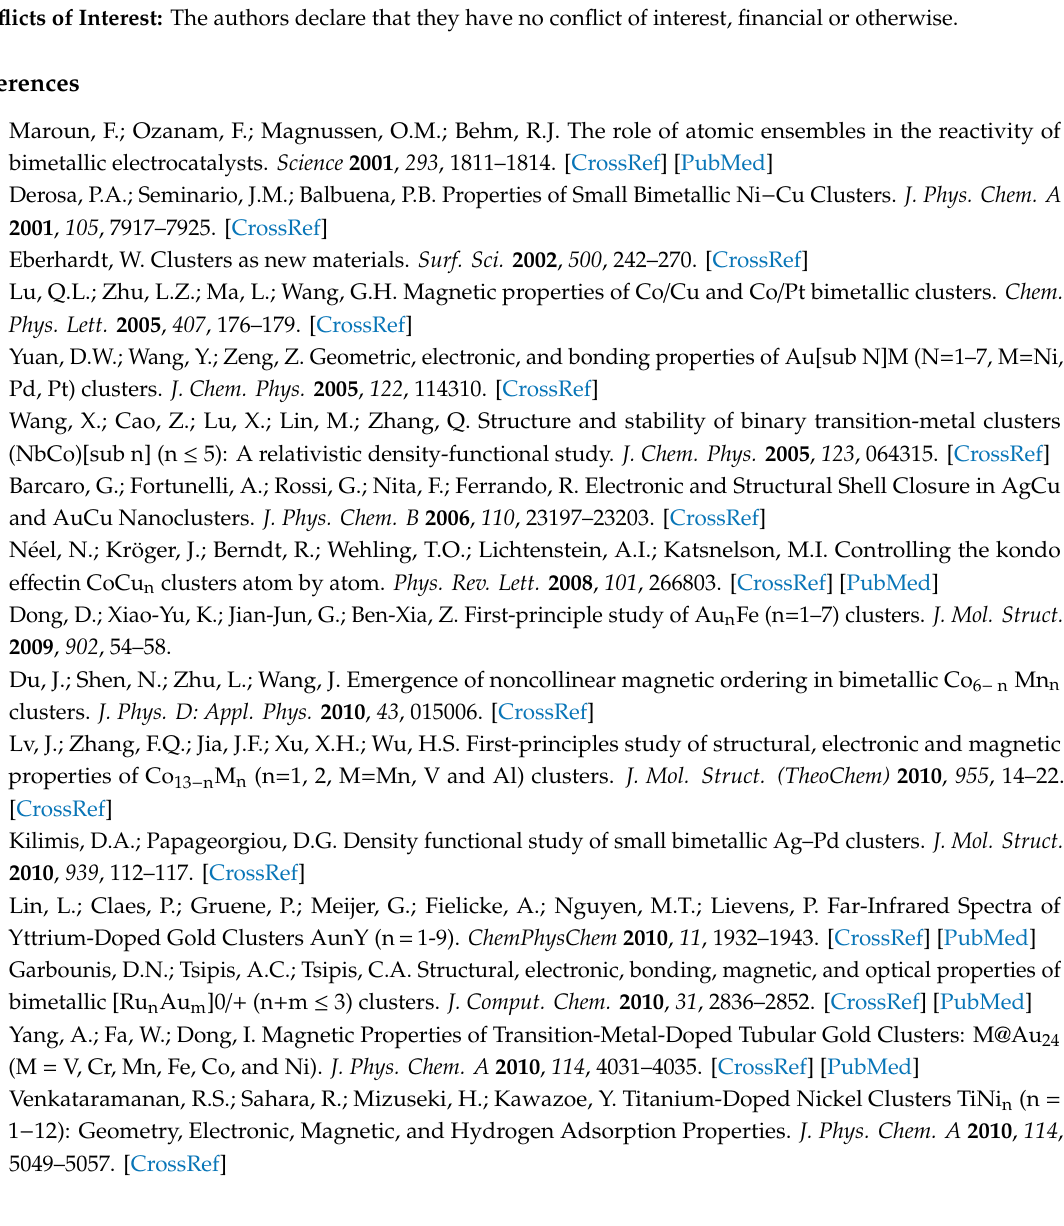
Al 2 Mn 3 clusters, Figure S8: Molecular structures of Al 2 Fe 3 clusters, Figure S9: Molecular structures of Al 2 Co 3 clusters, Figure S10: Molecular structures of Al 2 Ni 3 clusters, Figure S11: Molecular structures of Al 2 Cu 3 clusters, Figure S12: Molecular structures of Al 2 Zn 3 clusters, Figure S13: Molecular structures of Al 3 Fe 3 clusters, Figure S14: Molecular structures of Al 2 Fe 4